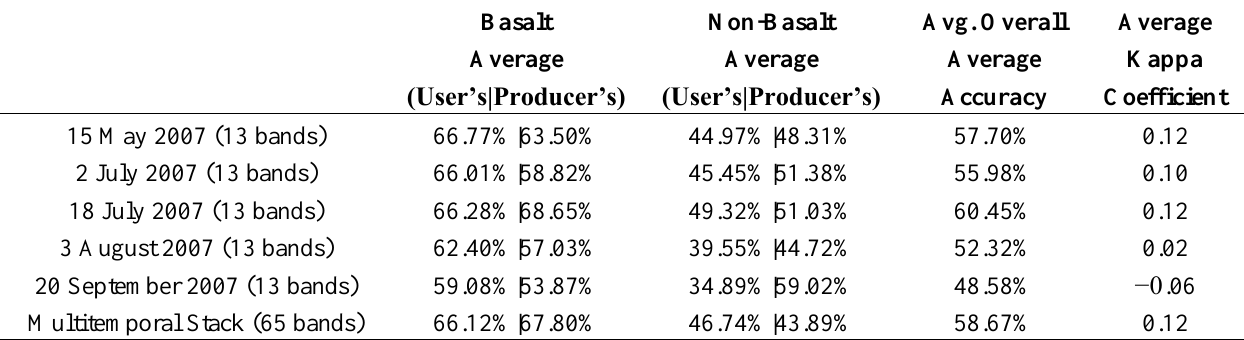
Table 1. A comparison of average producer’s, user’s and overall accuracy results obtained from the Robust Classification Method (RCM) using the Spectral Angle Mapper (SAM) classification method to detect basalt outcrops.